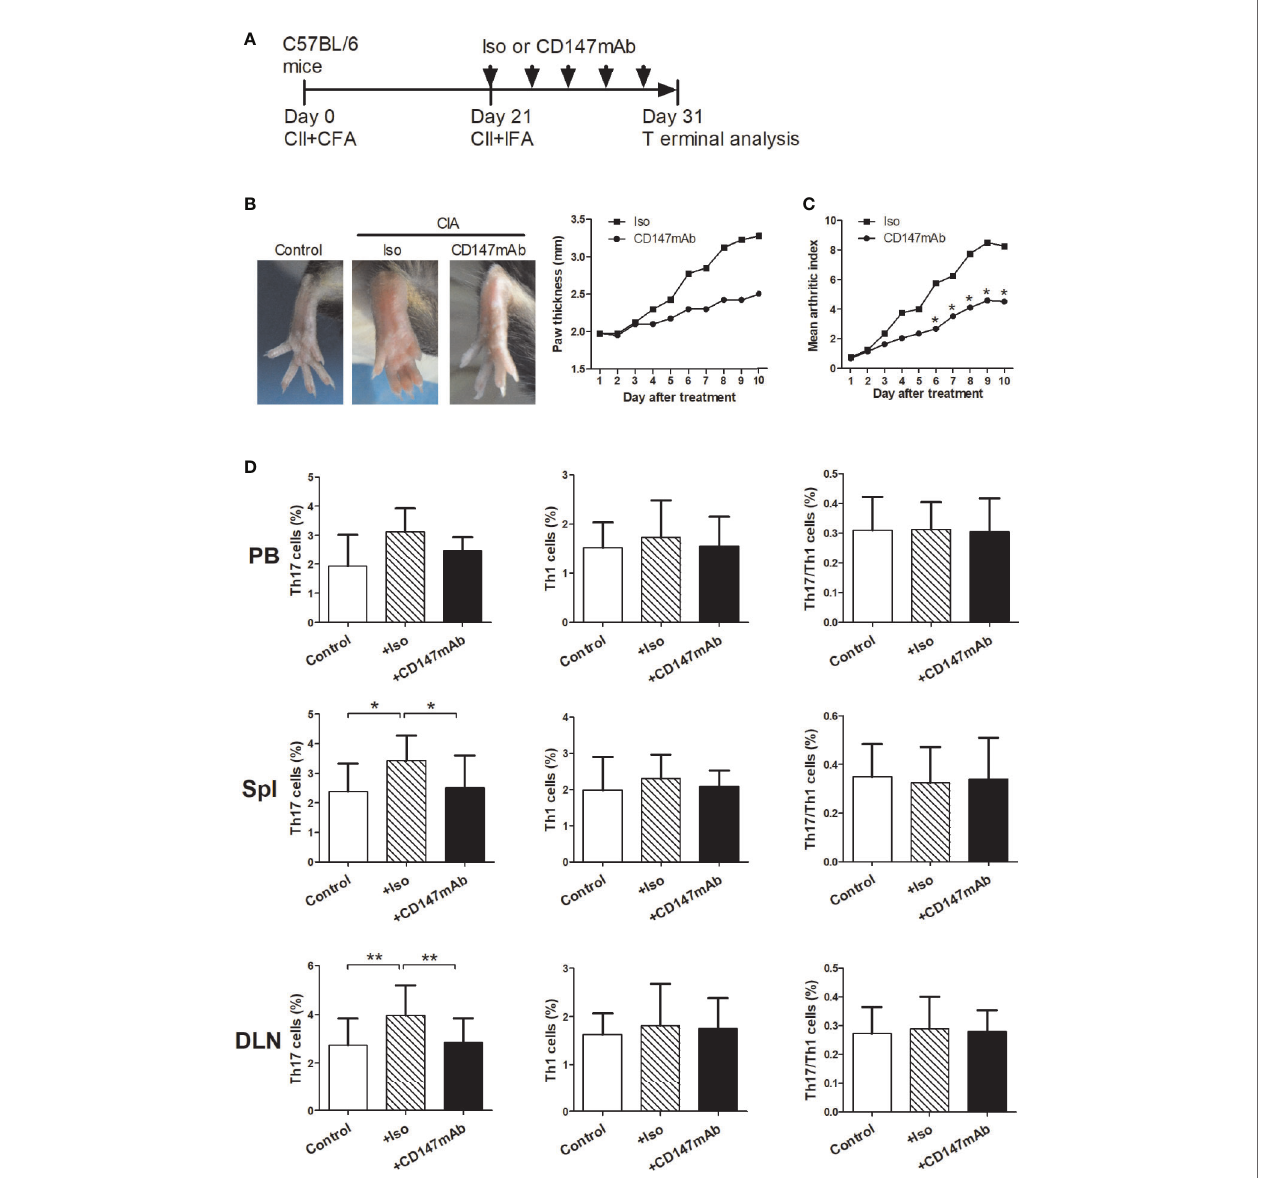
FIGURE 5 | Therapeutic effects of anti-CD147mAb in CIA model. (A) Experimental scheme for the analysis of CIA model. C57BL/6 mice were immunized on days 0 and 21, and treated with anti-mouse CD147 mAb (CD147 mAb) or isotype control mAb (Iso) at every other day for 10 days starting on day 21. (B) Representative hind paws from normal mice (Control), Iso and CD147 mAb treatment CIA mice (Day 31). The average thickness of both hind paws was measured (n = 4). (C) The mean arthritis index in CIA mice that were administrated Iso or CD147 mAb (n = 4). (D) Percentages of Th17, Th1 and Th17/Th1 cell in the PB, spleens (Spl) and draining lymph nodes (DLN) from Control and CIA mice treated with Iso or CD147 mAb (n = 4). * P < 0.05; ** P <